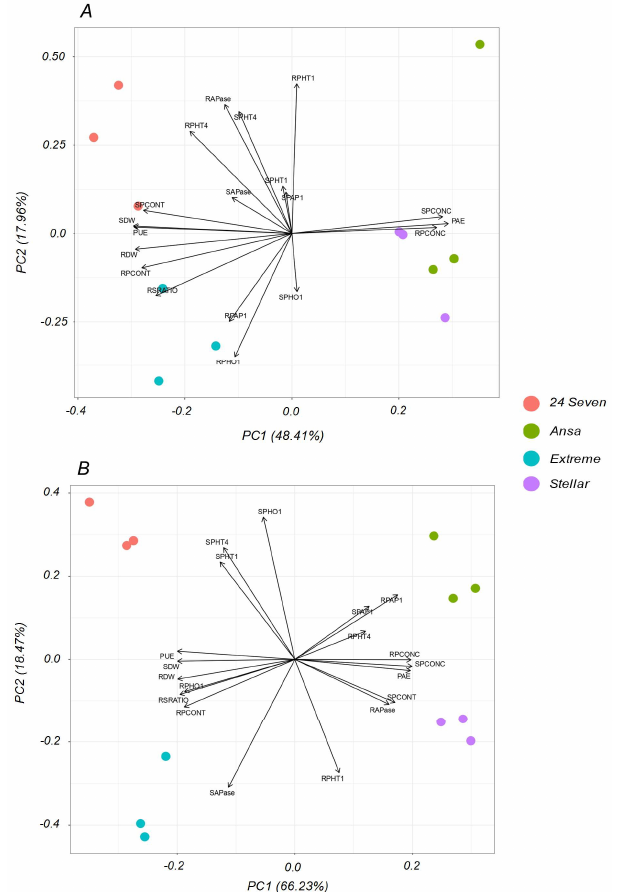
Figure 6. Principal component analysis (PCA) of different traits of four ryegrass cultivars hydroponically grown at optimal (0.1 mM P; ( A )); and deficient (0.01 mM P; ( B )) P conditions. Numbers in parentheses show the percent of the total variation explained by the PC1 and PC2, both representing 66.37% for optimal P and 84.7% for P deficiency of the total variance. Biplot vectors are trait factor loadings, whereas the position of individual cultivars is shown in colored circles. Abbrevia- tions: phosphorus acquisition efficiency (PAE), phosphorus utilization efficiency (PUE), shoot dry weight (SDW), root dry weight (RDW), root:shoot ratio (RSRATIO), shoot P concentration (SPCONC), root P concentration (RPCONC), shoot P content (SPCONT), root P content (SPCONT), shoot LpPHT1;1 expression (SPHT1), root LpPHT1;1 expression (RPHT1), shoot LpPHT1;4 expression (SPHT4), root LpPHT1;4 expression (RPHT4), shoot LpPHO1;2 expression (SPHO), root LpPHO1;2 expression (RPHO), shoot LpPAP1 expression (SPAP1), root LpPAP1 expression (RPAP1), shoot APase activity